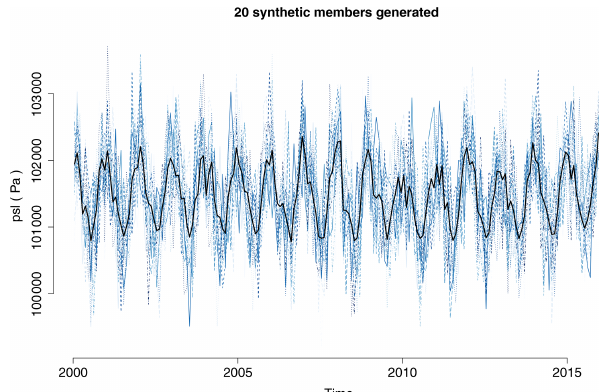
Figure 16. Example of 20 synthetic members of a single dataset ensemble generated by recipe_toymodel.yml . Shown are time series of surface-level pressure (psl) averaged over the region 30–50 ◦ N, 40 ◦ E–40 ◦ W, from 2000 to 2015, created from monthly mean data from ERA-Interim (Dee et al., 2011). With the user providing an es- timate for the standard error, e.g., from differences between differ- ent observational datasets, this diagnostic can be used to investigate the effect of observational uncertainty. For details, see Sect. 3.4.2.